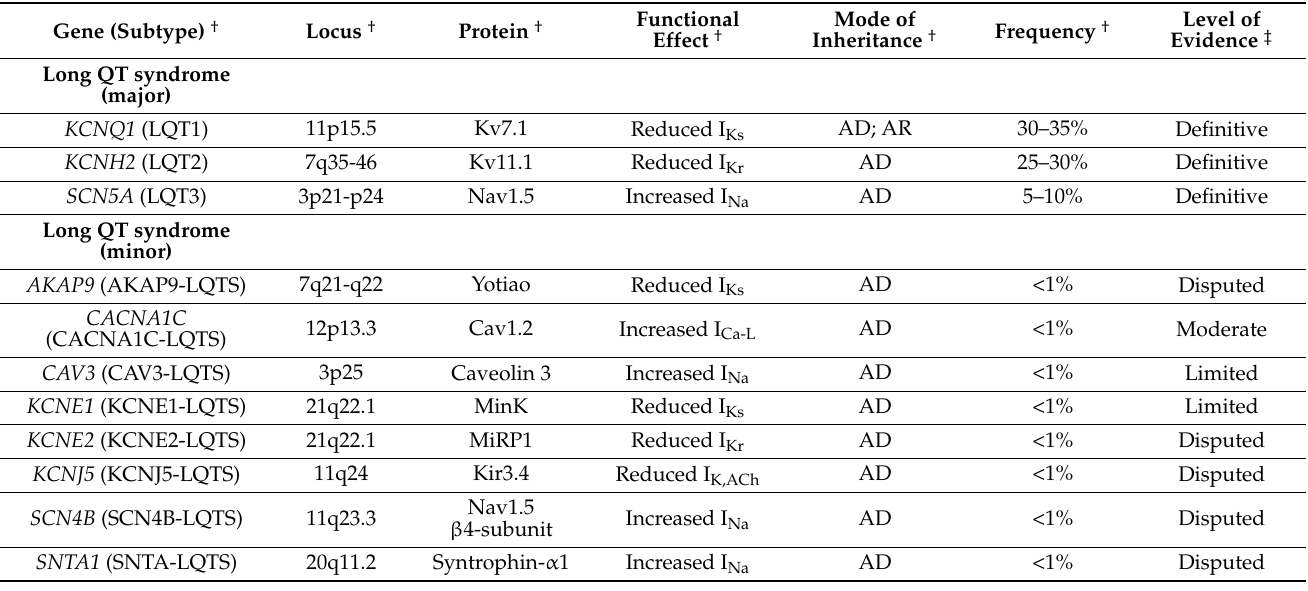
Table 1. Summary of the molecular basis of congenital long QT syndromes and multiorgan syndromes including long QT